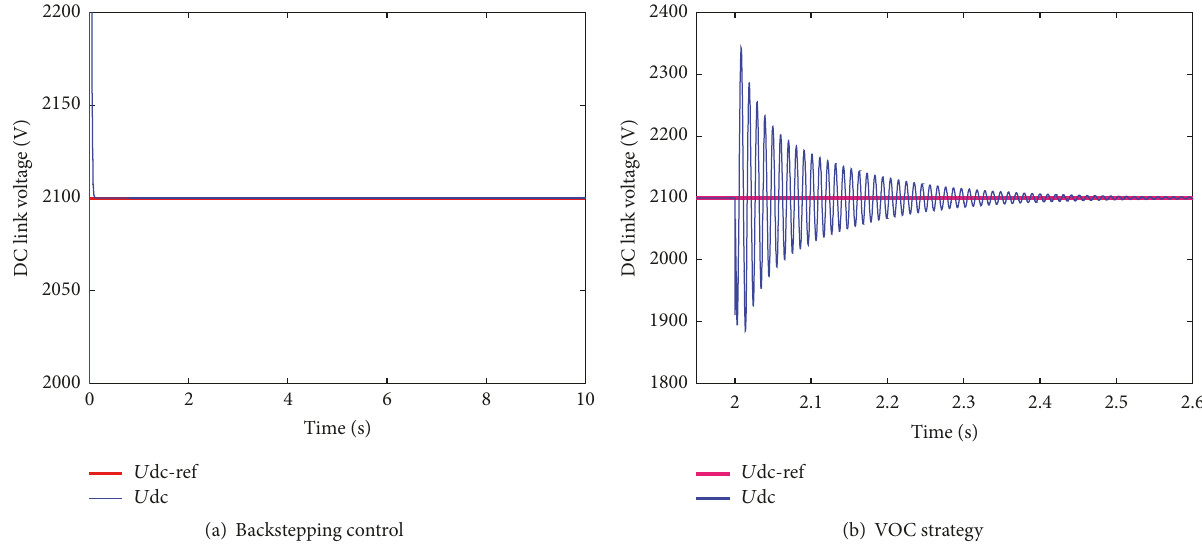
Figure 15: dc-link voltage (V) (with parameter variations).